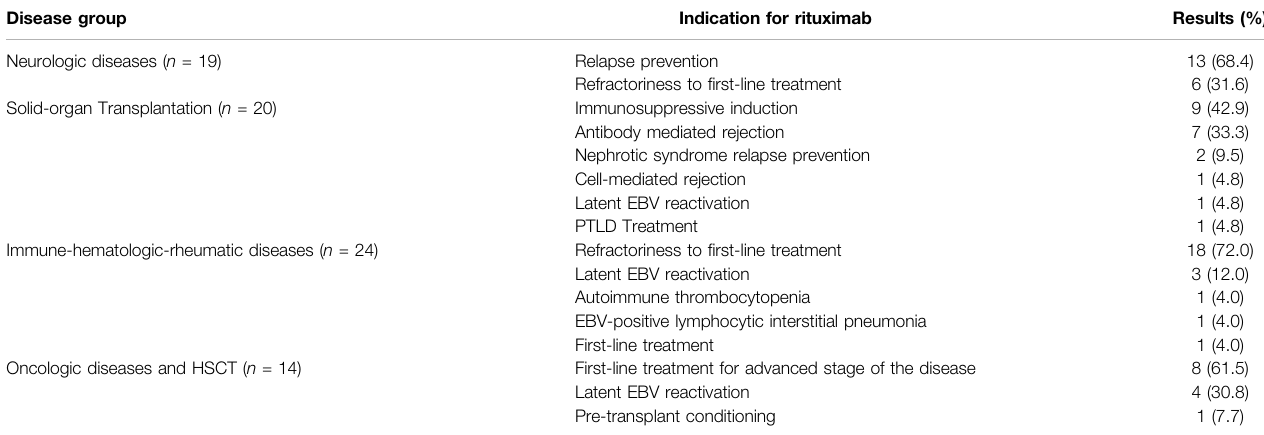
TABLE 1 | Rituximab indications according to disease group.